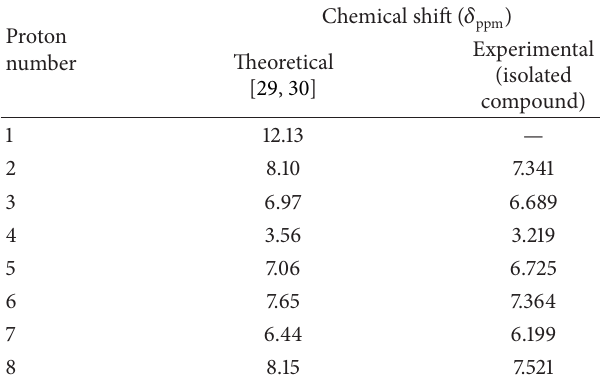
Table 2: Chemical shifts of P-coumaric acid in H 1 NMR spectra, 𝛿